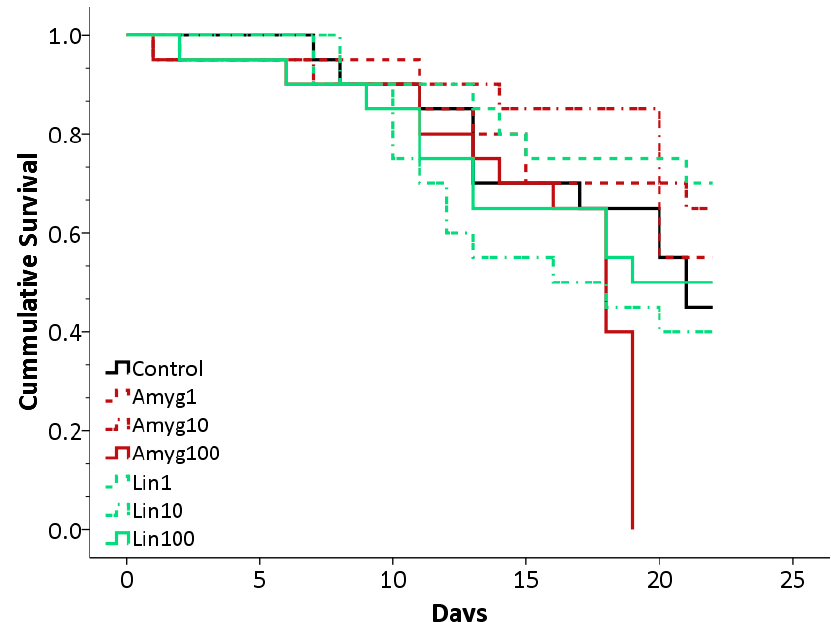
Figure 2. Survival plot for bees in the control, amygdalin and linamarin treatments. Amygdalin treatments in red, Linamarin in green and Control represented by a black line. Concentrations of 1 ng/ μ L shown by a dashed line, 10 ng/ μ L shown by dots and dashes and 100 ng/ μ L a full line.